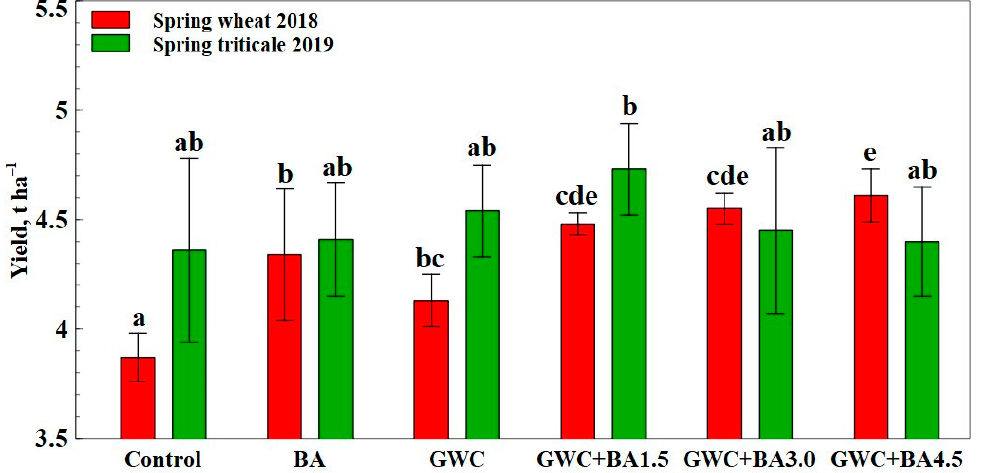
Figure 6. Two-year (2018–2019) data of the BA, GWC, and GWC + BA mixtures’ effect on spring wheat and spring triticale yields. The difference between the values with the same letter (a,b,c,d,e) was not statistically significant between the different materials when p < 0.01. BA—biofuel ash; GWC—green waste compost; GWC + BA1.5—green waste compost (20 t ha − 1 ) + biofuel ash (1.5 t ha − 1 ); GWC + BA3.0—green waste compost (20 t ha − 1 ) + biofuel ash (3.0 t ha − 1 ); GWC + BA4.5—green waste compost (20 t ha − 1 ) + biofuel ash (4.5 t ha − 1 ).